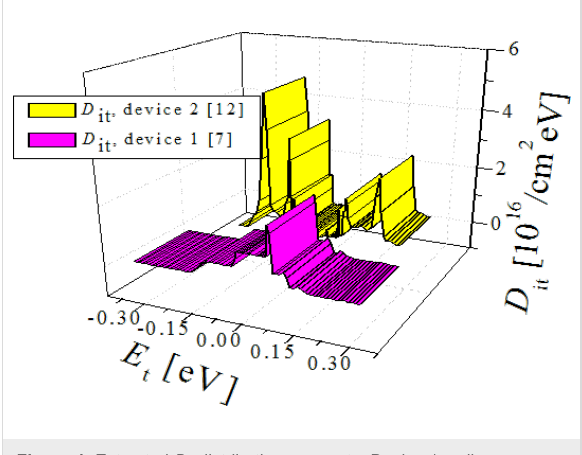
Figure 4: Extracted D it distribution, magenta: Device 1, yellow: Device 2.